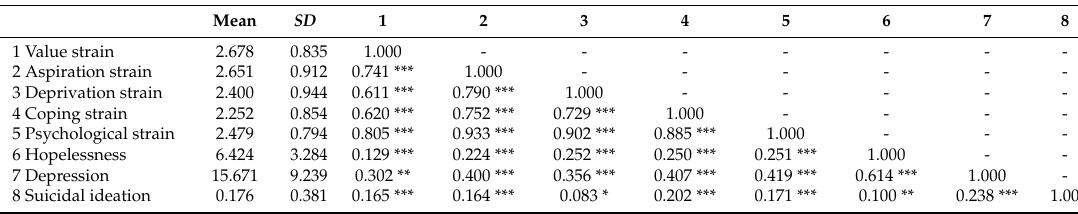
Table 1. Descriptive statistics and correlation matrix for psychological strain, hopelessness, depression, and suicidal ideation in